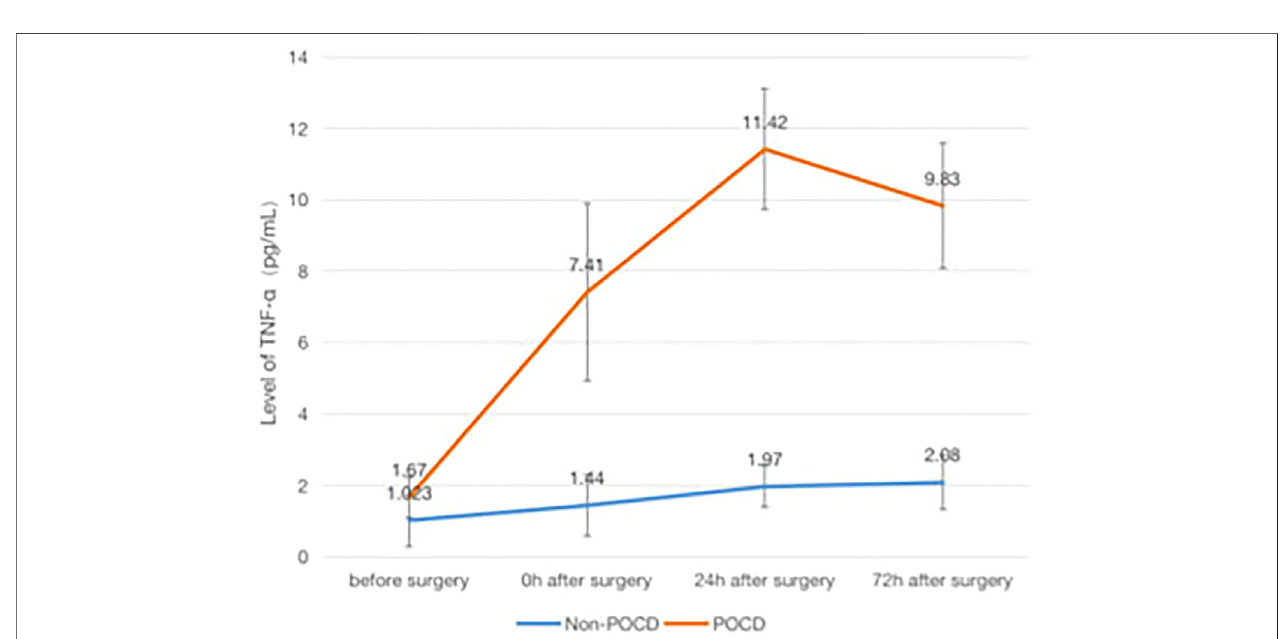
FIGURE 4 | Comparison of serum concentrations of TNF- α (pg/ml) Between Non-POCD and POCD groups before and after surgery 丨 There was no signi fi cant difference in the preoperative levels of TNF- α concentration in the Non-POCD group compared with postoperative levels. There was no signi fi cant difference in the preoperative levels ofTNF- α concentration in theNon-POCD group compared withPOCDgroup. Compared with preoperative levels, thelevels at 24th and 72nd hours after surgeries in the POCD group increased with statistically signi fi cance. The differences in the levels of TNF- α concentration between patients in the POCD and Non-POCD groups at the same time points postoperatively were statistically signi fi cant. Values are mean ± SD. n (cid:1) 61. * p < 0.05 vs. the preoperative level of S-100 β ; # p < 0.05 vs. the POCD group.